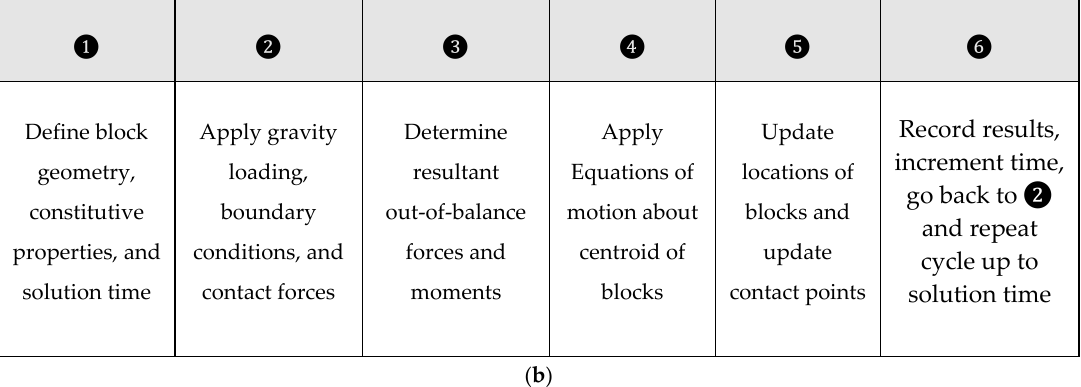
Table 1. Critical combinations for 0.5 m block UDEC simulation.